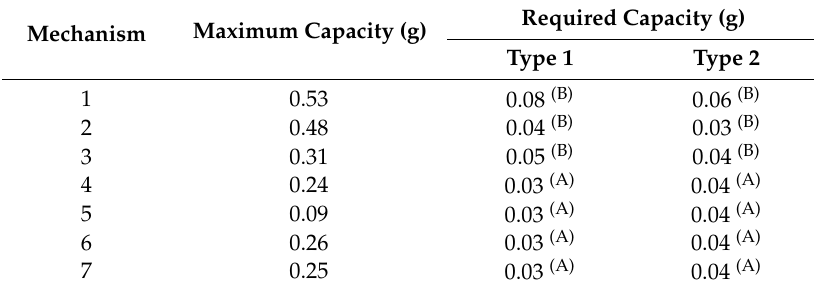
Table 3. Safety verification for seismic action by means of limit